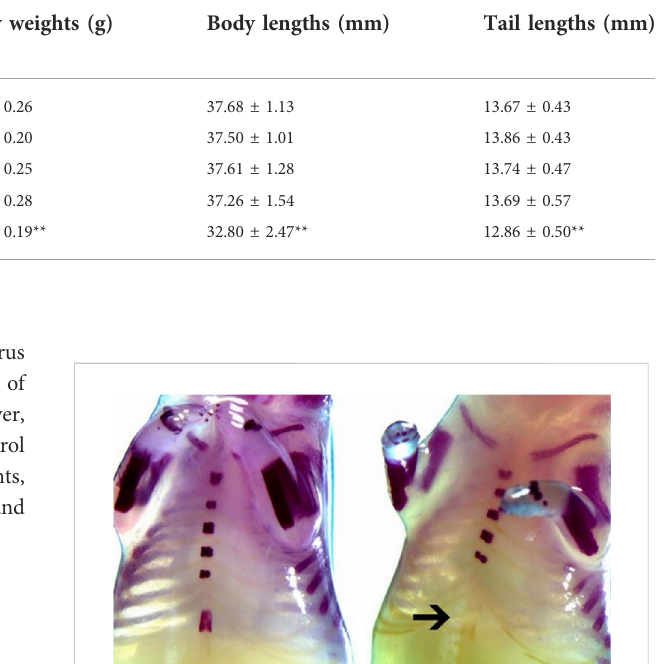
TABLE 2 Effect of water-extract sericin on growth and development of fetuses.